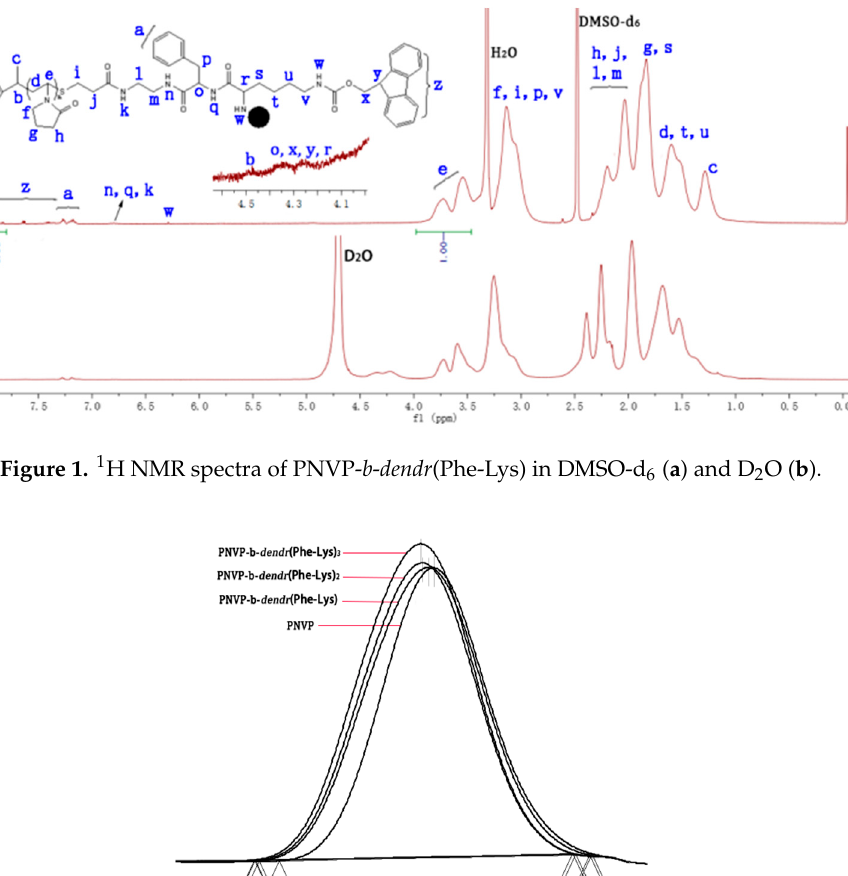
Table 1. Characterization of copolymers and their DOX-loaded micelles.